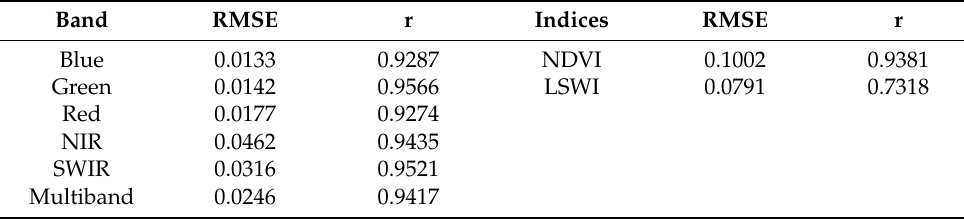
Figure 8. Images used for FSDAF verification: ( a ) Input data, coarse-resolution image, MODIS on 12 January; ( b ) input data, fine-resolution image, Sentinel-2 on 12 January; ( c ) input data, coarse- resolution image, MODIS on 26 April; ( d ) output data Sentinel-2-like image, on 26 April, predicted by FSDAF; ( e ) original Sentinel-2 image on 26 April. All images are displayed in true color and same size. Table 4. Accuracy assessment of the FSDAF model applied to the simulated dataset.